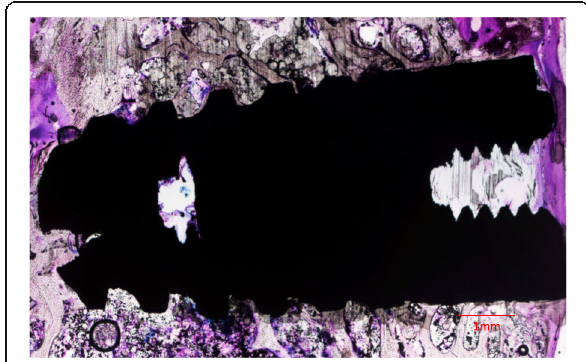
Fig. 5 Histological section of standard implant in rabbit tibia stained with methylene blue and basic fuchsin